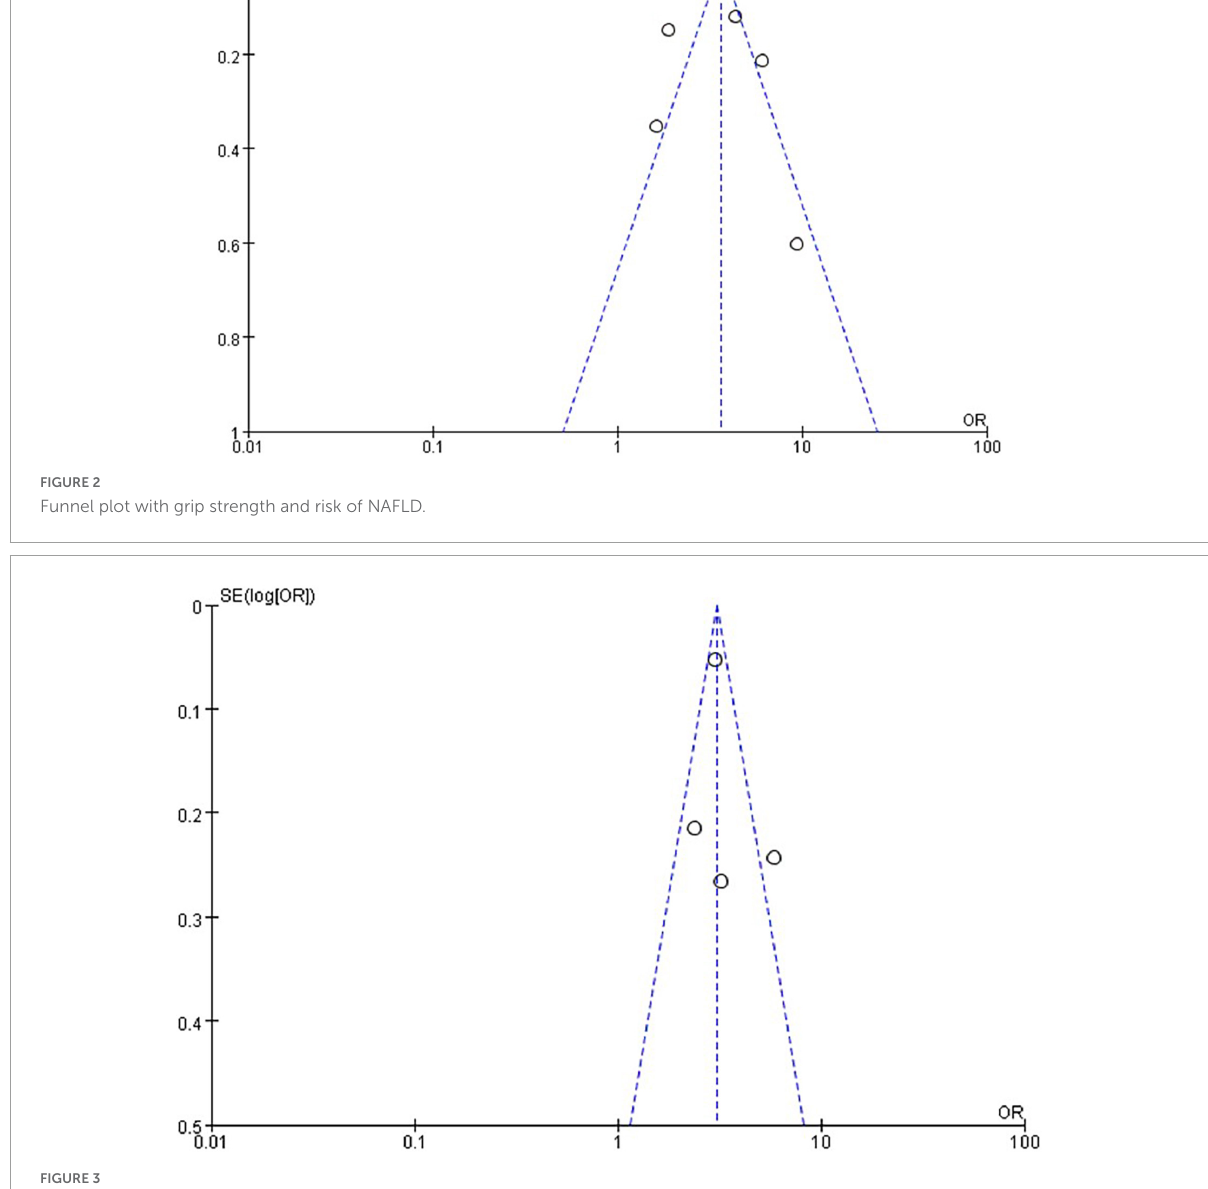
OR = 4.02, 95% CI: 2.11–7.65) compared to the studies using GS (OR = 2.69, 95% CI: